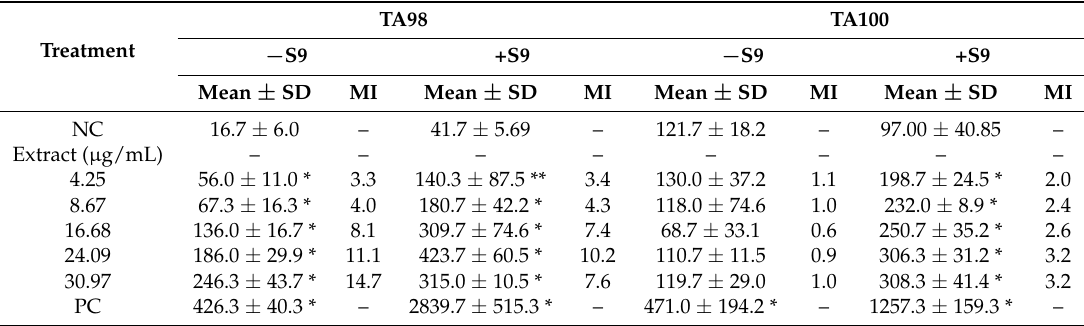
Table 1. Revertant/plate, standard deviation and mutagenicity index (MI) in the strains TA98 and TA100 of S. typhimurium after treatment with different doses of the extract from T. guianensis , without ( − S9) and with (+S9) metabolic